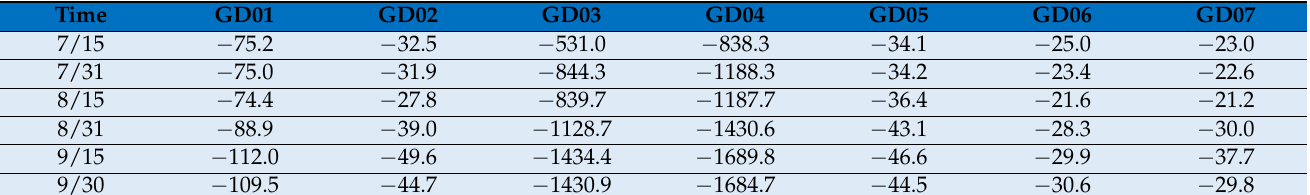
Table 6. July–September GNSS displacement monitoring sequence (unit/mm).